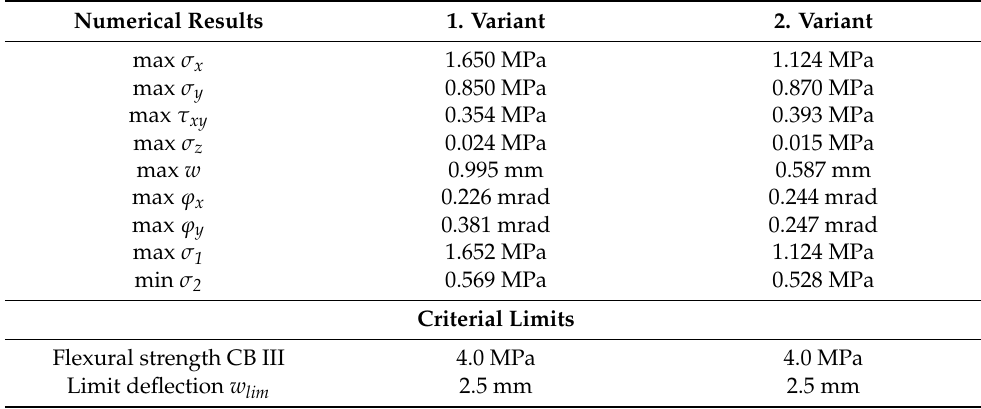
Table 4. Numerical results—maximal values and limit values according to standard TP